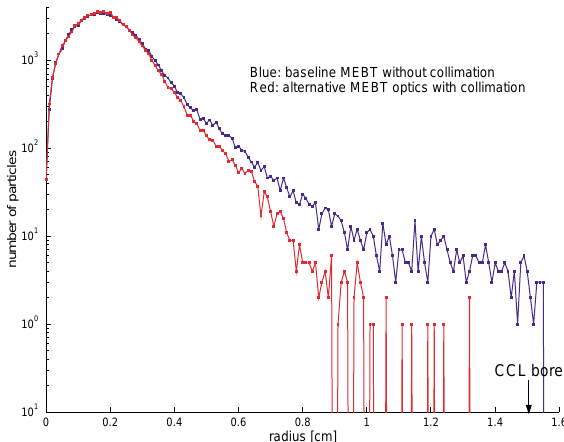
FIG. 14. (Color) Radial beam distribution at 171 MeV for the hybrid halo mitigation solution. 97% of the halo with r . 9 mm is removed with the combination of two collimators and modified MEBT optics (lower curve). The upper curve corre- sponds to the baseline